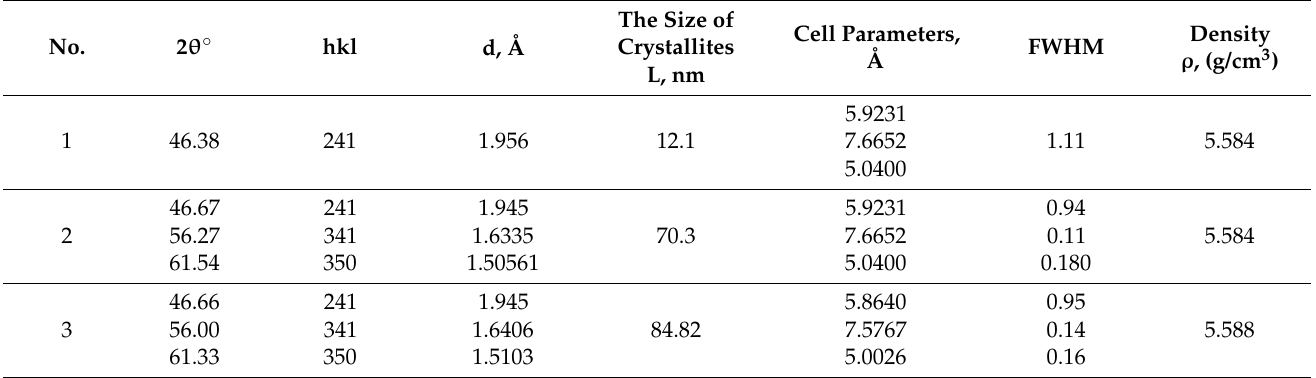
Table 2. Crystallographic parameters of ZnSeO 3 nanoprecipitates in SiO 2 /Si templates calculated from XRD data.